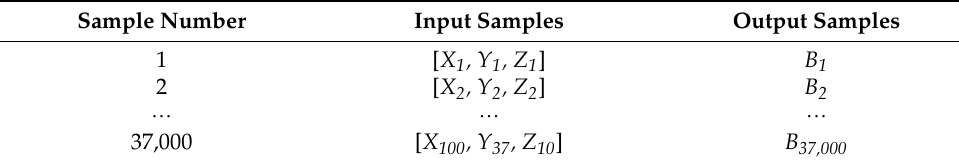
Table 1. The sample set.